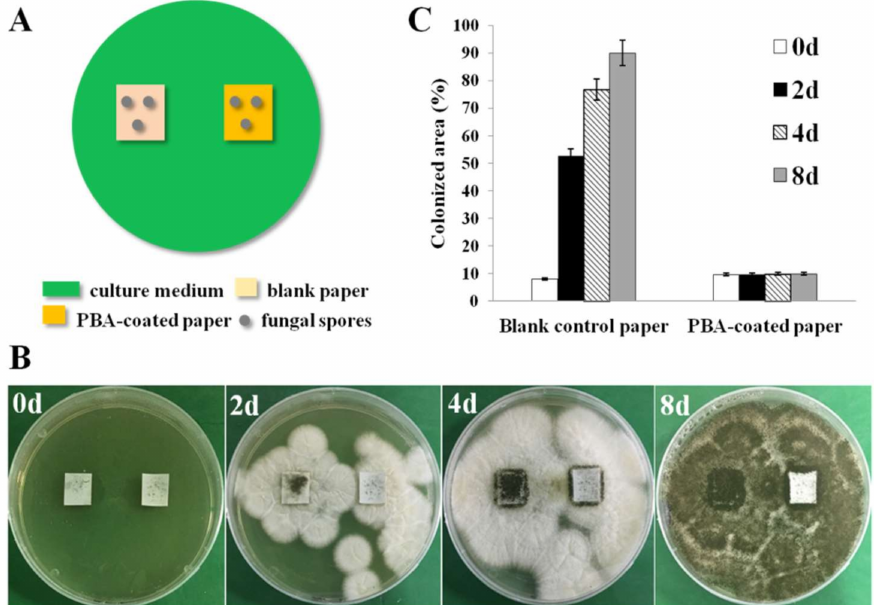
Figure 5. Antifungal evaluation under severe top-fouling conditions. ( A ) Schematic representation of the antifungal model. ( B ) Pictures of the antifungal adhesion effect against A. niger for eight days. ( C ) Fungal average colonized area after 0, 2, 4 and 8 days of